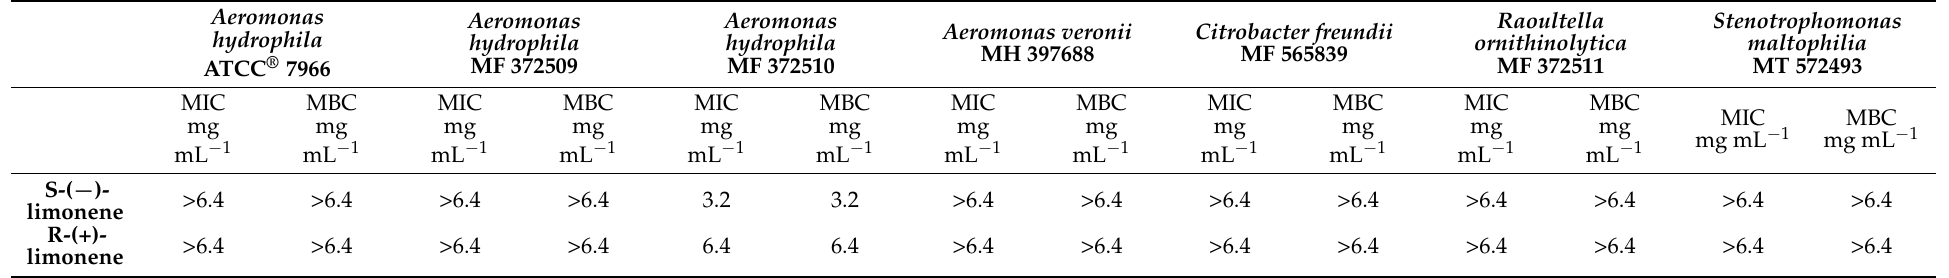
Table 1. Minimum inhibitory concentrations (MICs) and minimum bactericidal concentrations (MBCs) of the optical isomers of limonene against six clinical isolates of pathogenic bacteria from fish and a standard